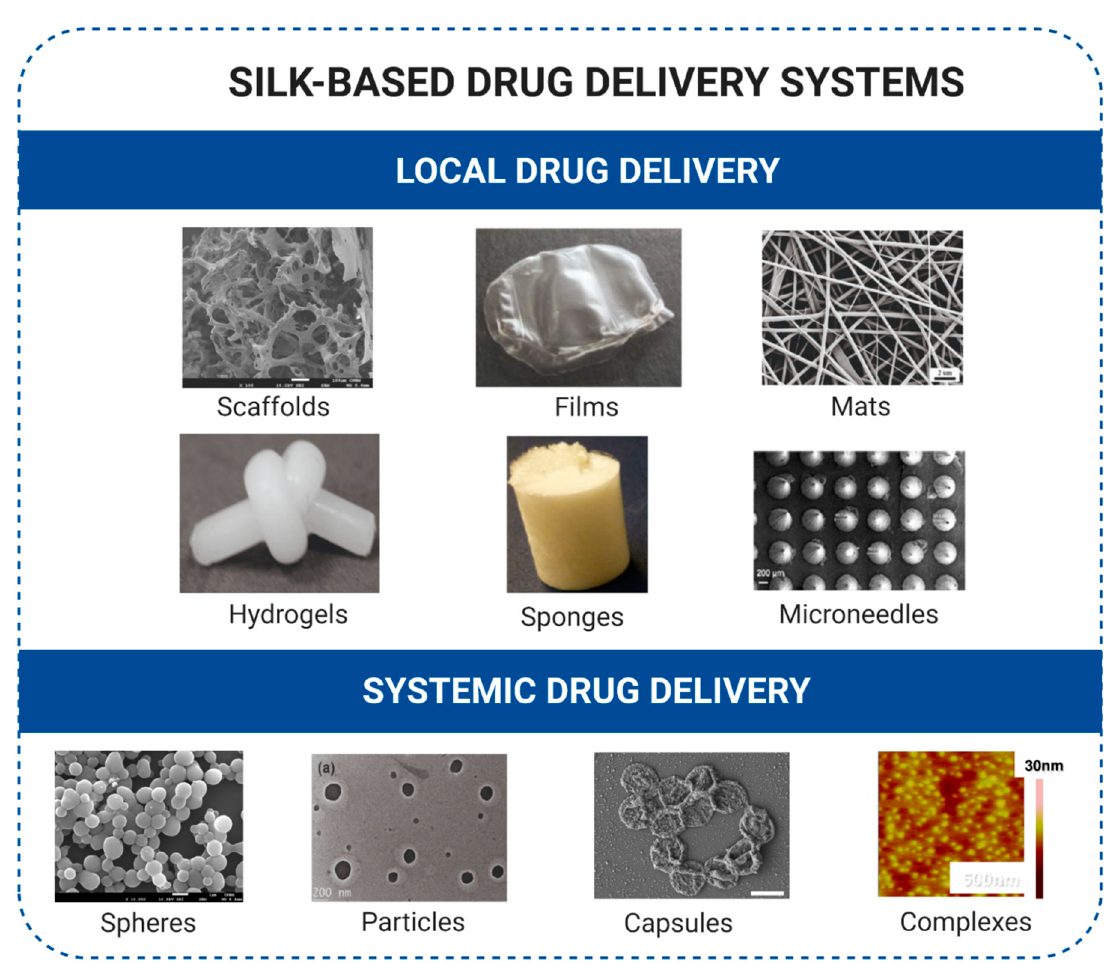
Figure 2. Silk-based systems used for local and systemic controlled delivery of therapeutic agents. Images are reproduced with permission from the cited articles for scaffolds [141], film [142], fiber mats [143], hydrogels [144], sponges [128], mi- croneedles [145], spheres [125], particles [146], capsules [147], and complexes [83]. Created with BioRender.com accessed on 31 August 2021.